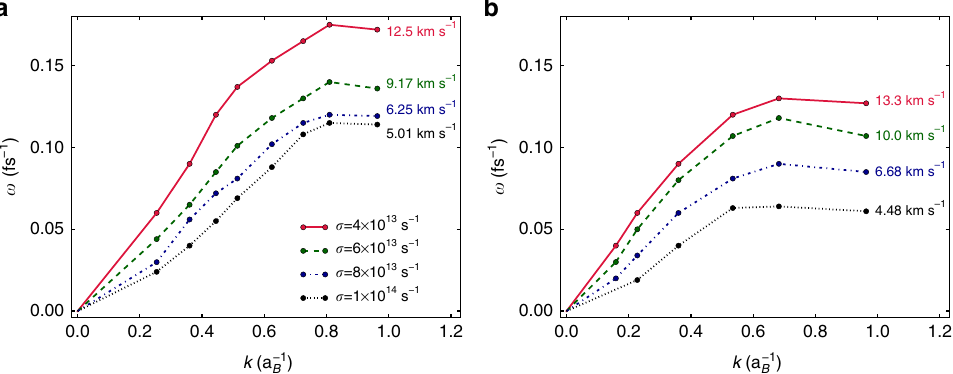
k (a B −1 Figure 3 | Dispersion relations of the ion acoustic modes for warm dense aluminium with varying friction strength. ( a ) Shows data from orbital-free density functional theory (OF-DFT) simulations, whereas ( b ) shows data from fully classical MD simulations. Both were run in the canonical ensemble at T e ¼ T i ¼ 3.5eV and r ¼ 5.2gcm (cid:2) 3 , using a Langevin thermostat with different friction strengths, s . The annotated numbers give the sound speeds of the ion acoustic waves in the system as obtained from the constant gradient at small wavenumbers, k